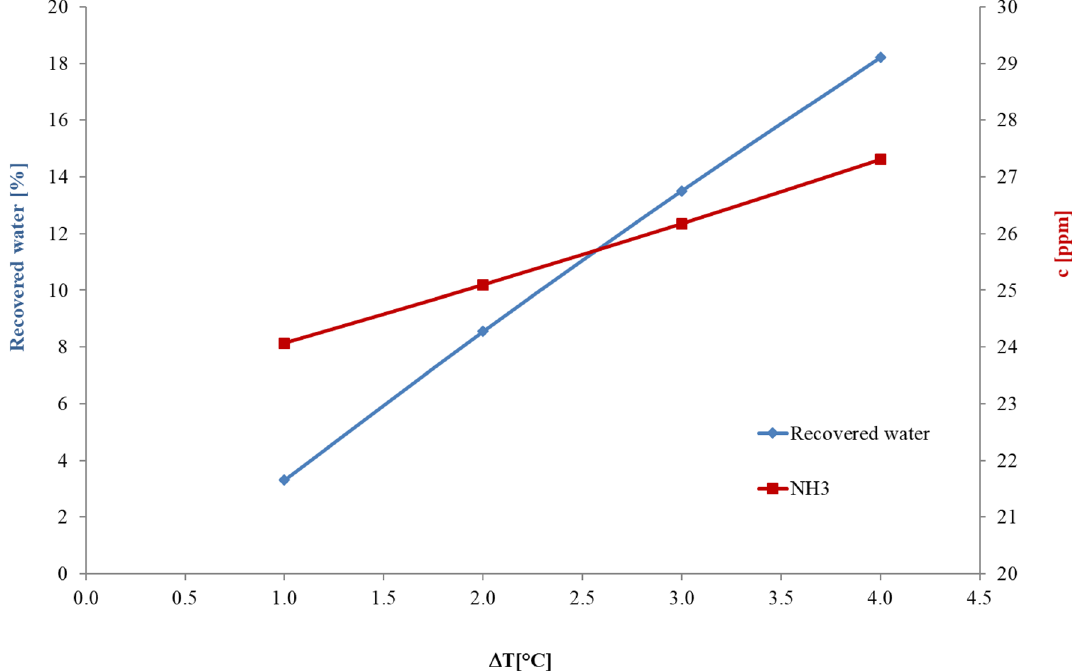
Fig. 5 Recovered water and ammonia concentration (c) versus ΔT for configuration 1. Feed temperature = 45 °C; RH feed =